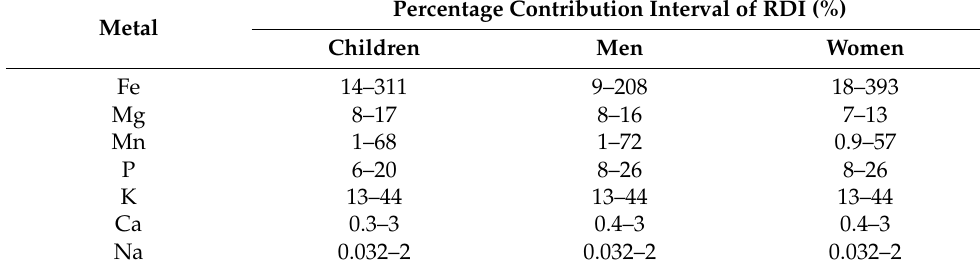
Table 5. Percentage contribution interval of RDI of each